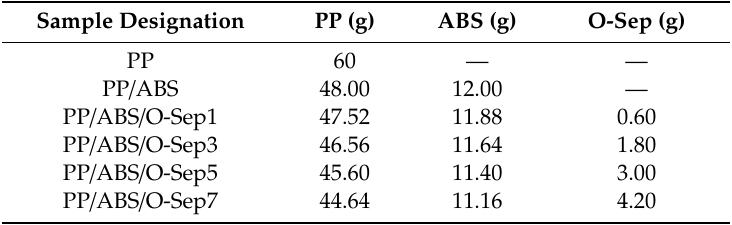
Details of sample designations. Abbreviations: Polypropylene (PP), acrylonitrile-butadiene-styrene graft copolymer (ABS), and sepiolite